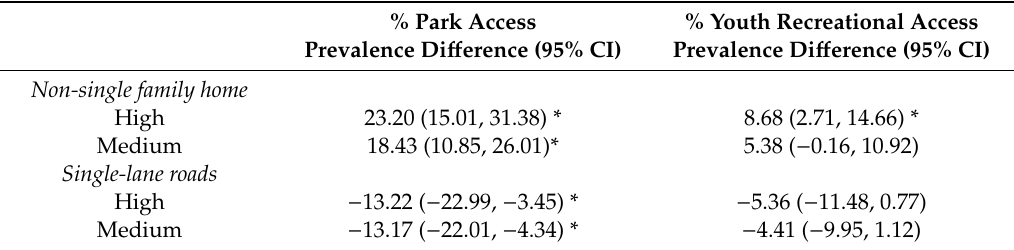
Table 3. Associations between state-level recreational access and built environment characteristics a